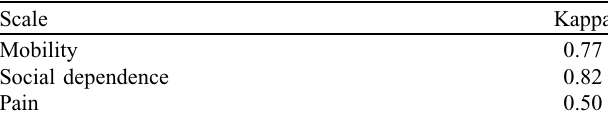
Table 5. Inter-observer